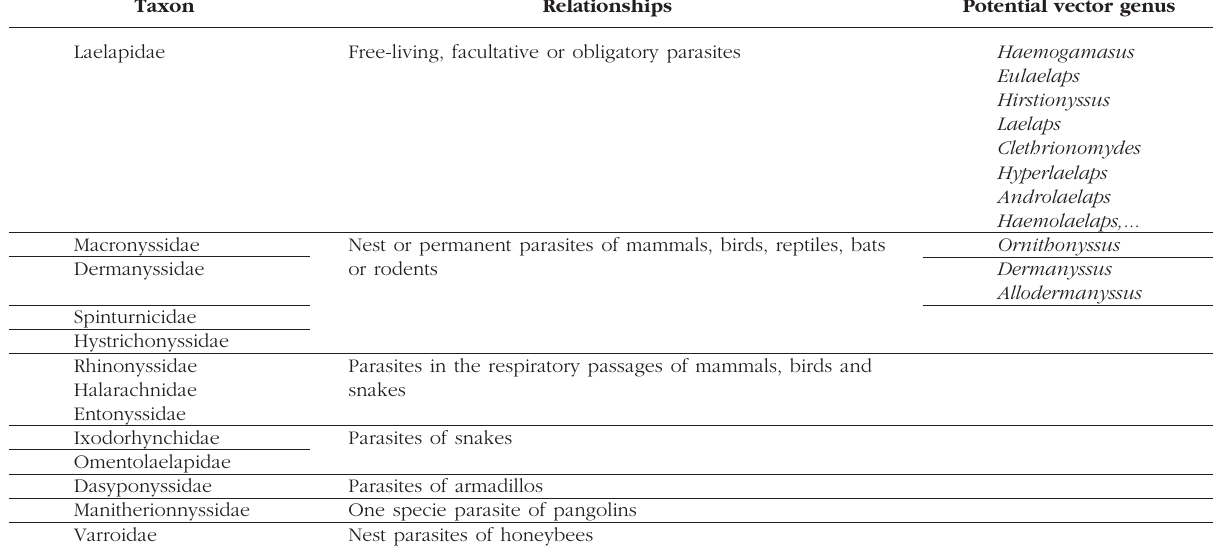
Table I. – Classification and feeding relationships of the Dermanyssoidea (modified from Radovsky, 1985).